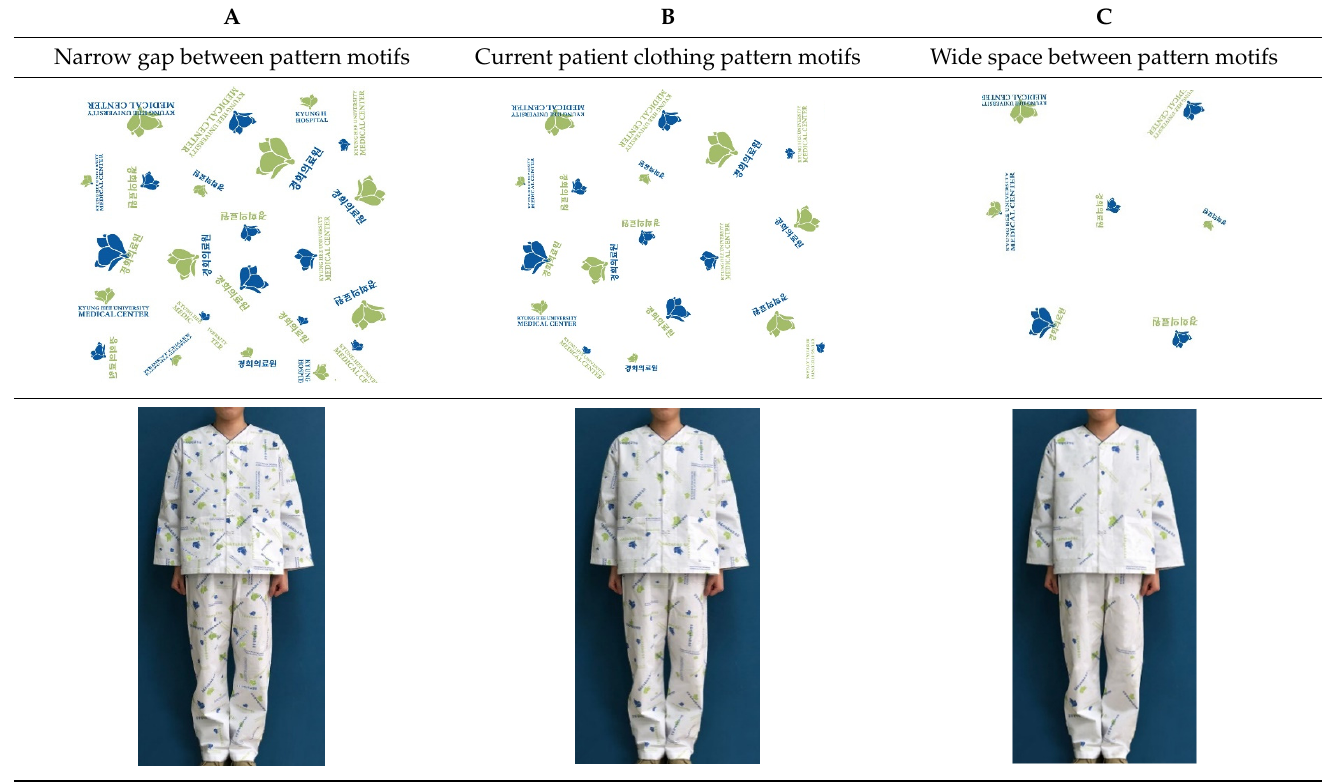
Table 5. Relaxation healing characteristics: patient clothing design stimulus.